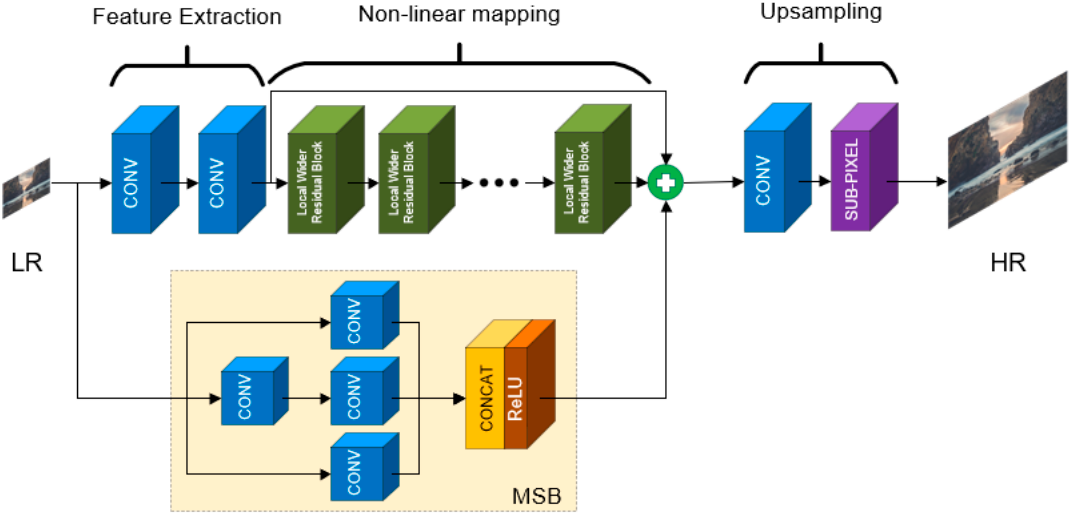
Figure 9. ERN network structure.